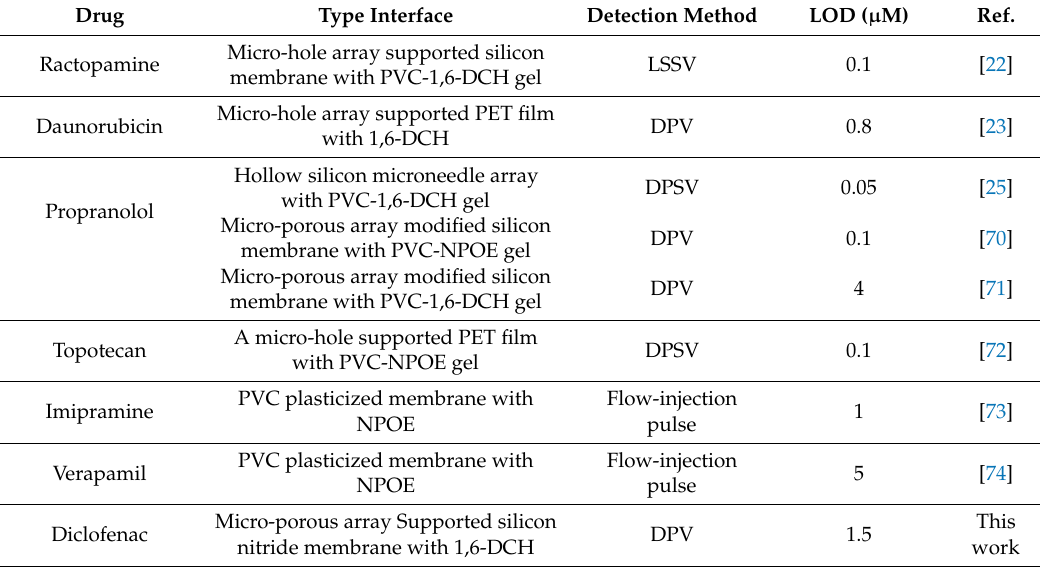
Table 3. The microporous membrane proposed demonstrated good performance in modifying a liquid–liquid interface and promising analysis to detect diclofenac as representative of nonsteroidal anti-inflammatory drugs. Nevertheless, the achieved limit of detection 1.5 µ M DCF can be improved by using di ff erential pulse stripping voltammetry (DPSV) as detection method, which has proven to o ff er improved detection capability [69,70]. Table 3. Comparison of the micro-porous Si3N4 membrane with other reported membranes as ion detection platforms for di ff erent drug molecules. Drug Type Interface Detection Method LOD ( µ M) Micro-hole array supported